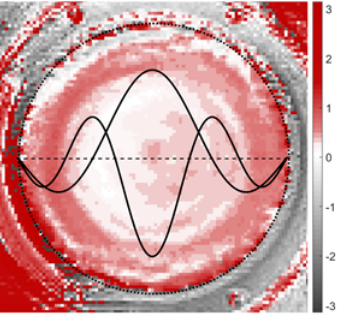
Figure 4. Phase of 2D field scan with 0.6 % LP 02 , 0.4 % LP 03 , and 2.7 % LP o content (enhanced color 11